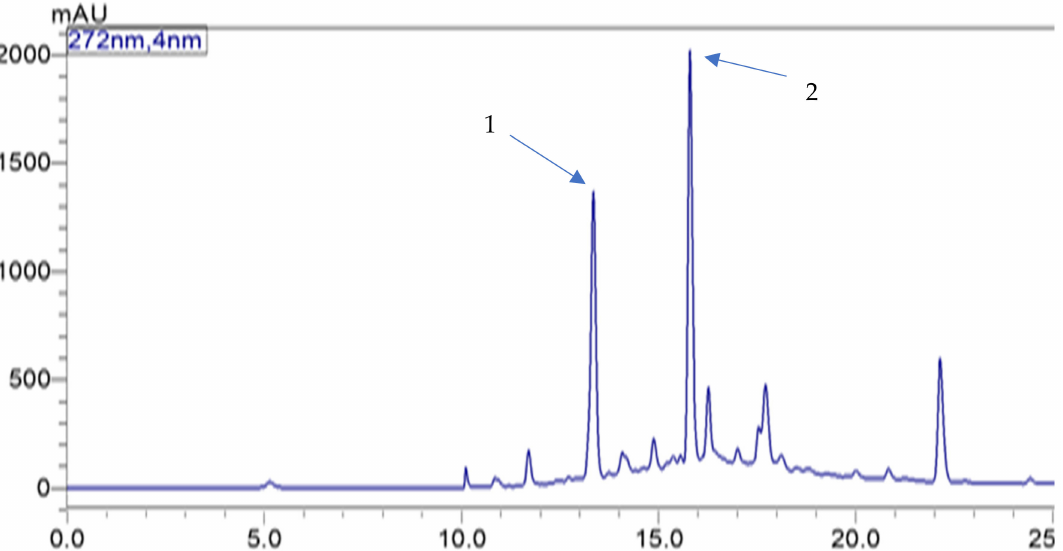
Figure 1. Chromatogram of phenolic compounds in the Natal plum–Marula nut bar. Major peaks 1 and 2 represent cyanidin 3- O -glucoside and cyanidin 3- O -sambubioside,